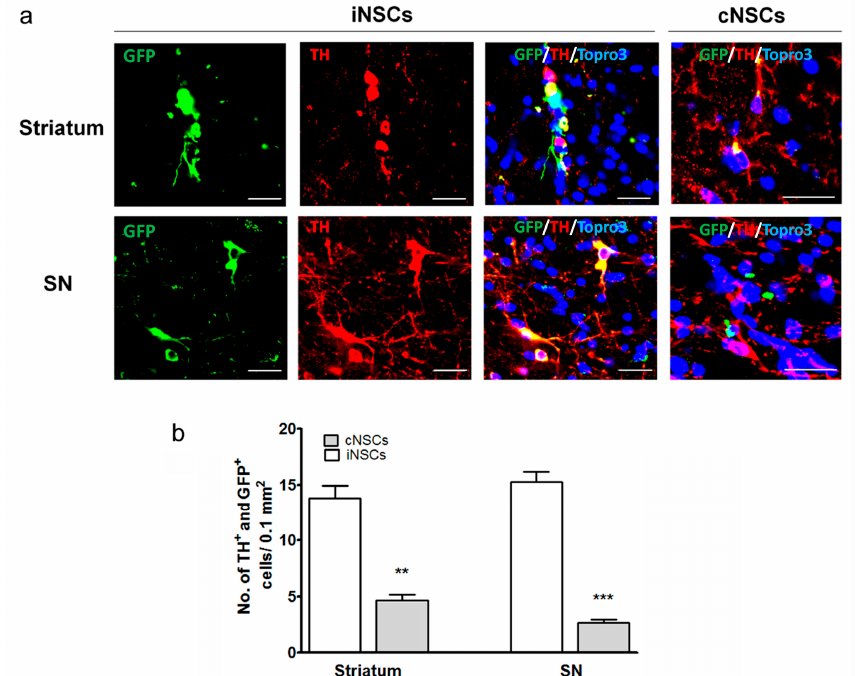
Figure 5. DA differentiation of engrafted iNSCs ( a ) Representative photomicrograph of GFP-positive iNSCs and cNSCs (green) differentiated into DA neurons in striatum and SNpC as determined by co-staining with TH (red). Blue colors show Topro-3 nuclear marker. Scale bars = 30 µm; ( b ) results are presented as triple stained cell counts per 0.1 mm 2 areas. ** p < 0.01, *** p < 0.001 vs. cNSCs ( n = 6). 2.4. Engrafted iNSCs Improved Motor Performance in the 6-OHDA-Induced PD Mouse Model In apomorphine-induced rotation test [31], PBS, iNSCs, and cNSCs were injected at eight weeks after 6-OHDA injection, a time point at which contralateral rotations were over 7 turns/min. The rotational scores are shown in Figure 6.